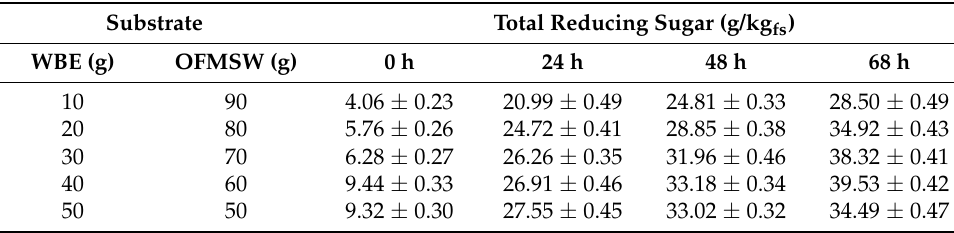
Table 1. Optimization hydrolysis process of OFMSW with different concentrations of